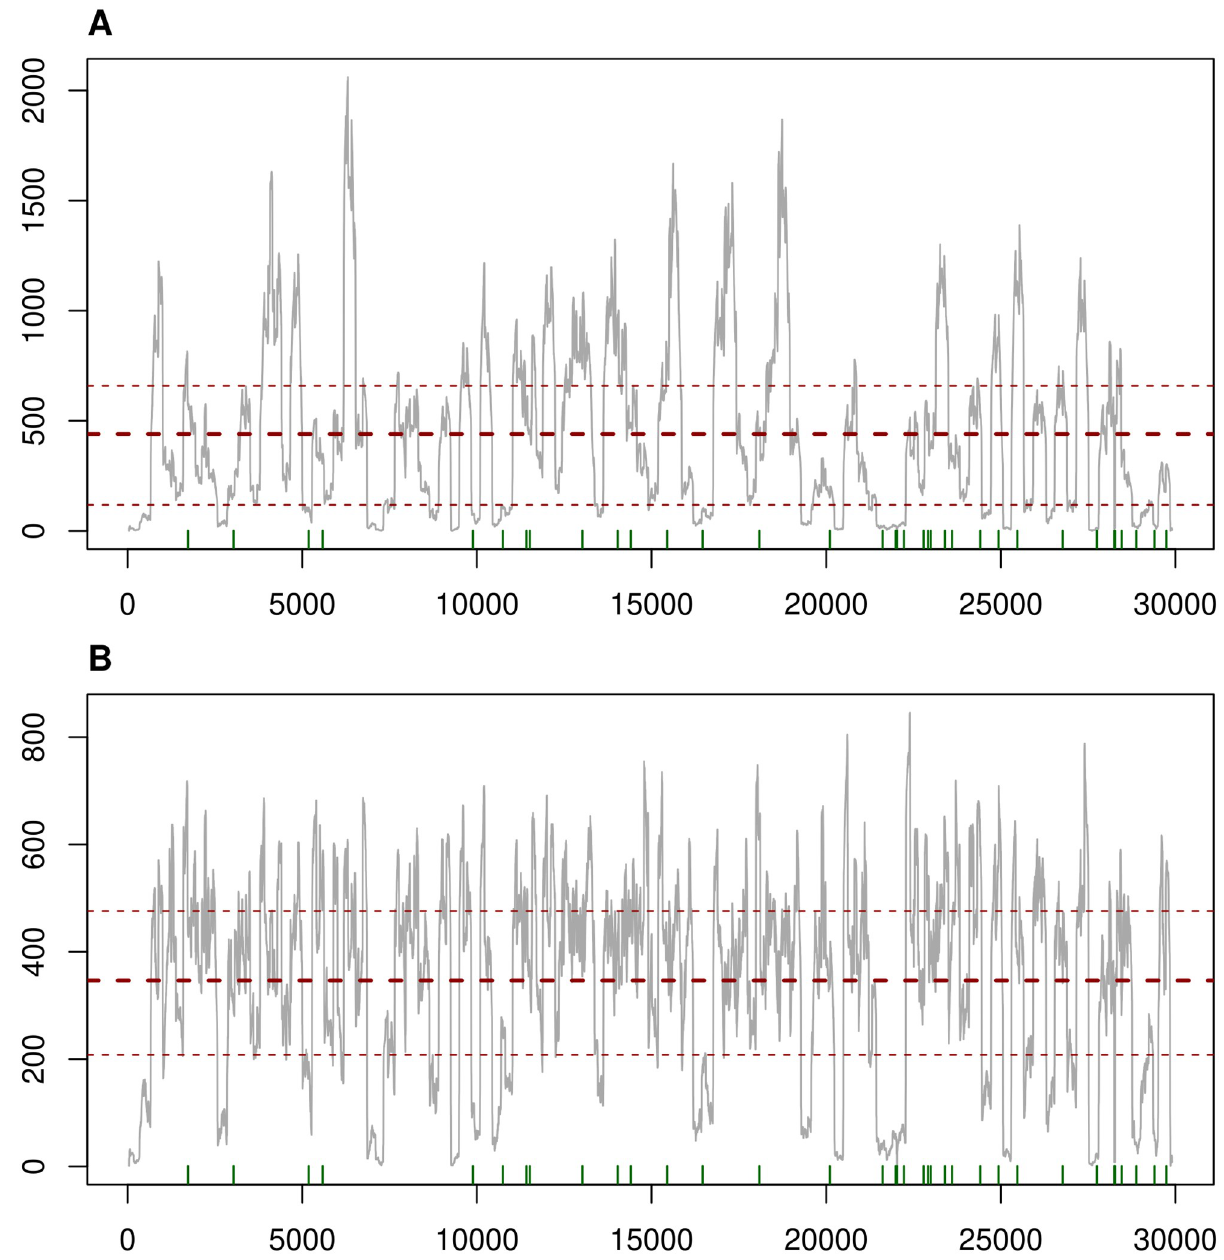
Fig 6. (A) Example of read depth counting all alignments and (B) evened out read depth by the resampling feature of using our pipeline. The x-axis shows the genomic position, whereas the y-axis represents the read depth of each position, shown as a gray line. The middle red dashed line shows the mean of read depth across the genome, and the thinner dashed lines show the first and third quartile of read depth distribution. Green bars on the x- axis show the positions of polymorphisms discovered using all alignments (A) and the read depth after resampling the alignments along genomic windows